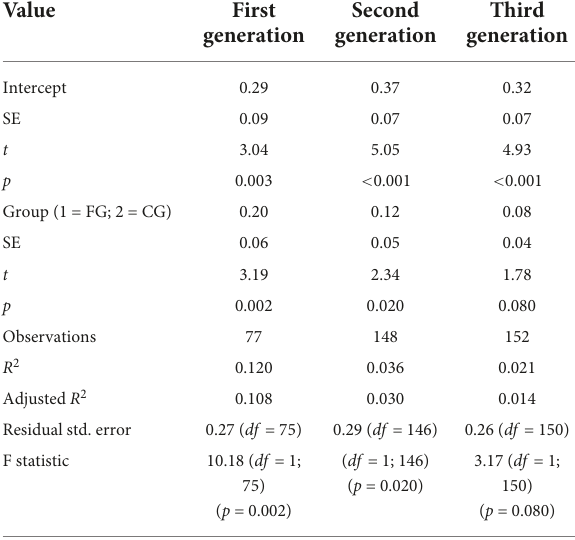
TABLE 2 Prediction of SOS-10 based on the focal and comparison groups throughout generations.